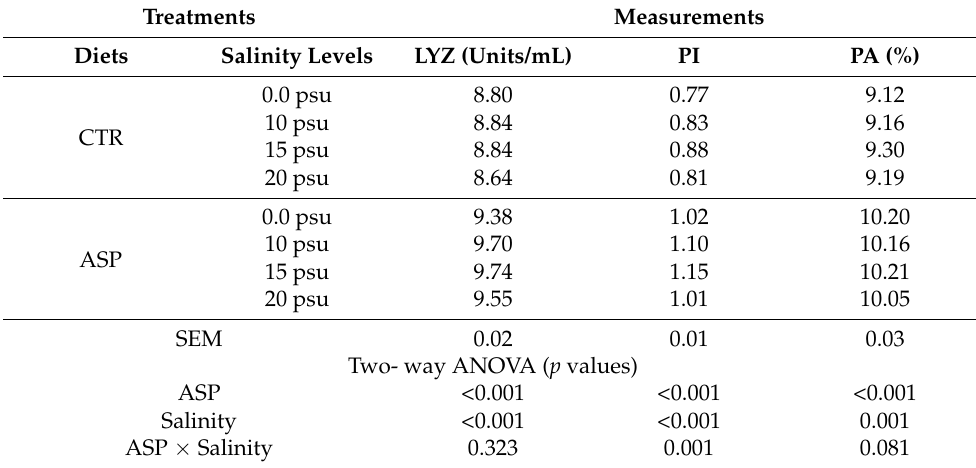
Table 2. Non-specific immunity parameters of Nile tilapia fed a basal diet (CTR) compared to those fed on diets supplemented with Aspergillus oryzae (ASP) for 12 weeks and exposed to different salinity levels for 15